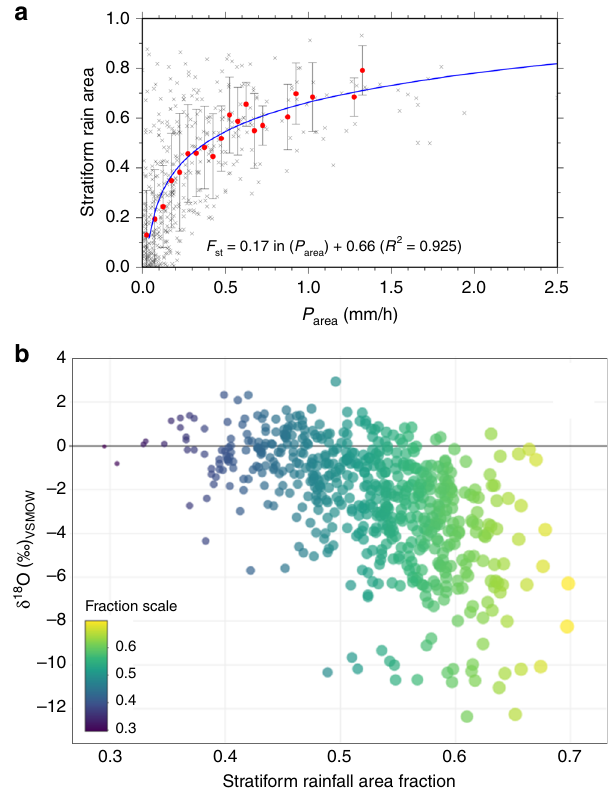
Fig. 4 Stratiform rainfall area fraction and δ 18 O ( ‰ ) relationship for a long- term monitoring station in the Caribbean coast of Costa Rica during 2013 – 2017. a Relationship between stratiform rainfall area fraction ( F st ) and the area-averaged rainfall amount over the 5° × 5° longitude/latitude box centered at the 28 Millas station during the observation period (March 2014 – September 2017). Red circles with error bars represent the average and standard deviation in precipitation intensity bins for each 0.05 mm/h interval up to 1.5 mm/h. Blue curved line shows a logarithmic regression of averaged values. b Stratiform rainfall area fraction and stable isotope composition δ 18 O relationship (Adj. R 2 = 0.30; P < 0.001). Stratiform rainfall area fraction is color and size coded. The horizontal black line represents 0.0 ( ‰ ) in δ 18 O as a